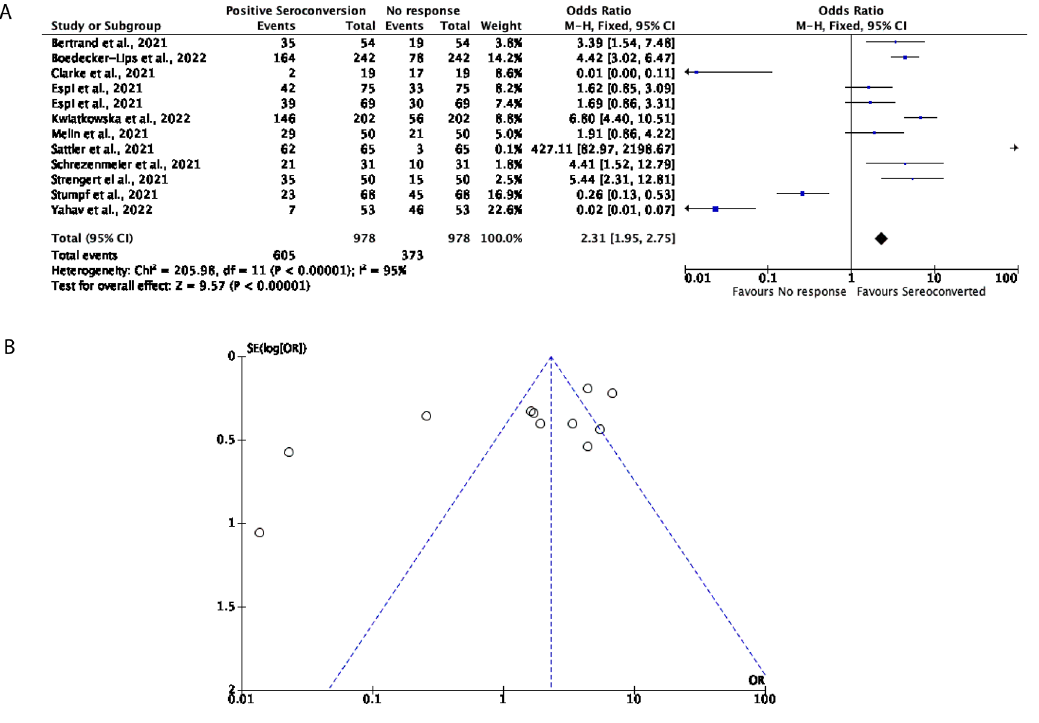
Figure 5. A total of 62% of Dialysis Patients (DPs) and Kidney Transplant Recipients (KTRs) elicited an effective cellular response following two doses of a COVID-19 mRNA vaccine. (A) Forest plot comparison of the number of DPsandKTRswhodevelopedacellularresponseaftertwodosesofanmRNAvaccine(OR=2.31,95%CI=1.95-2.75, P < 0.00001, I 2 = 95%). (B) Funnel plot evaluating heterogeneity when comparing cellular response in DPs and KTRs after two doses of an mRNA vaccine. Significant heterogeneity was observed ( P < 0.00001, I 2 =